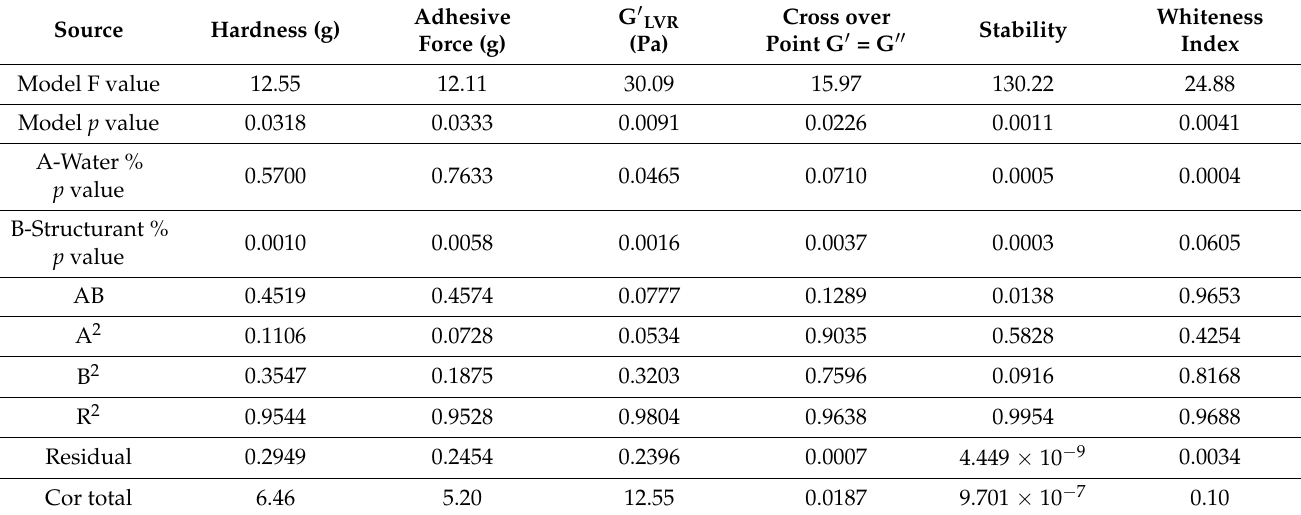
Table 2. Analysis of variance for the responses resulted in the analysis of emulsion oleogels.